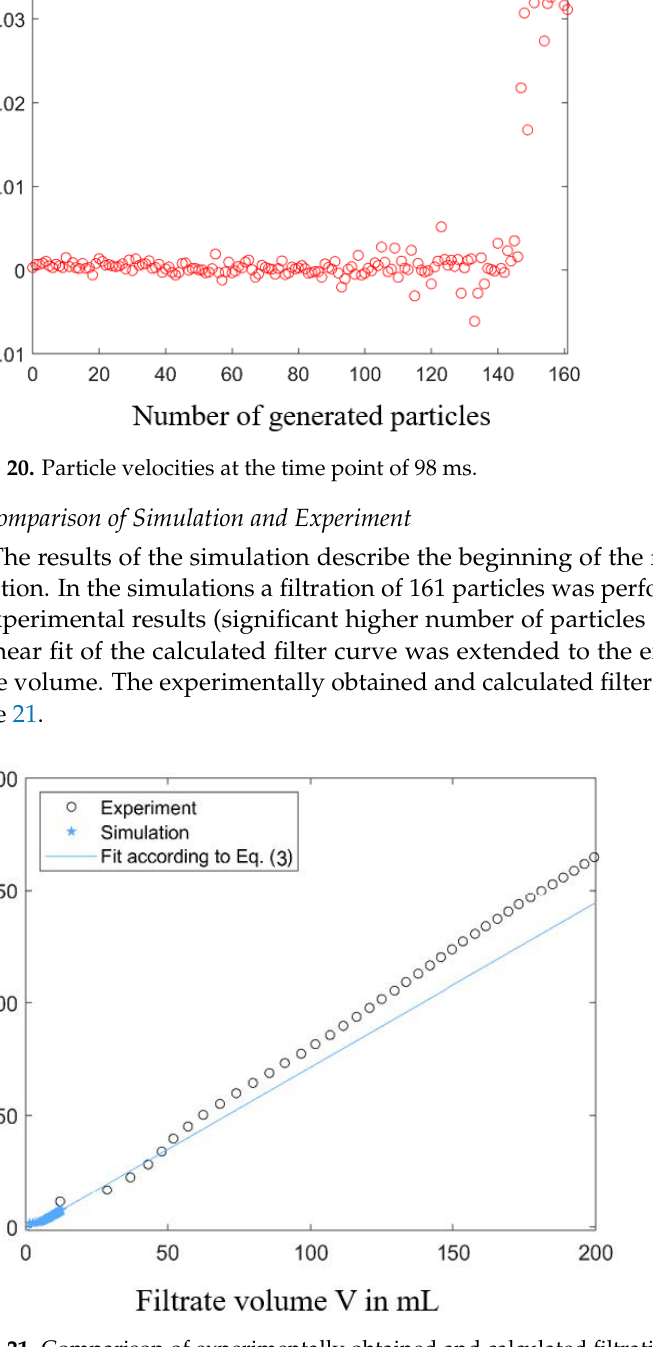
Figure 21. Comparison of experimentally obtained and calculated filtration curves.